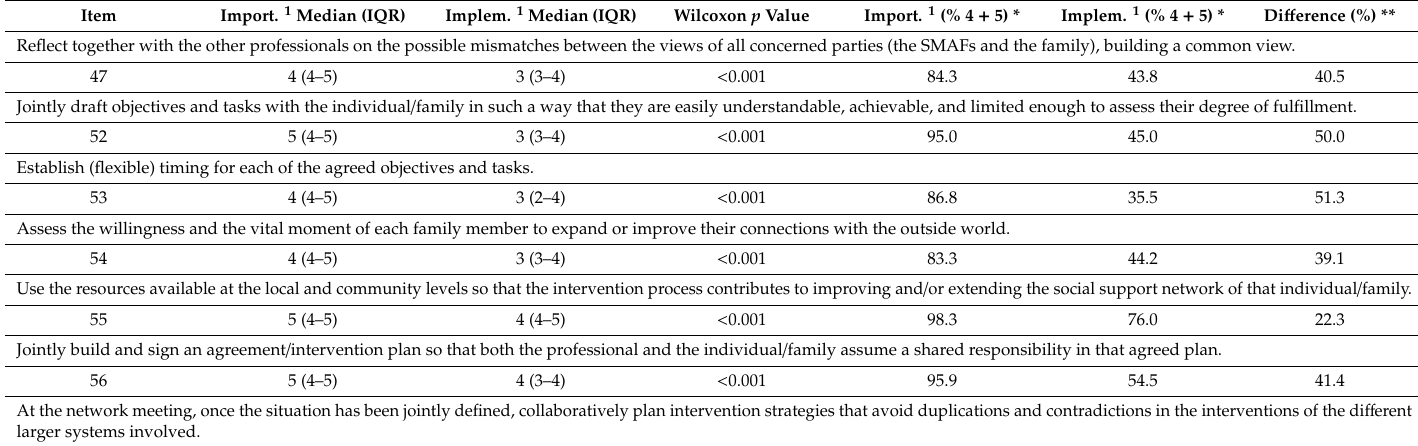
Table 3. Factor II: assessment of the interprofessional